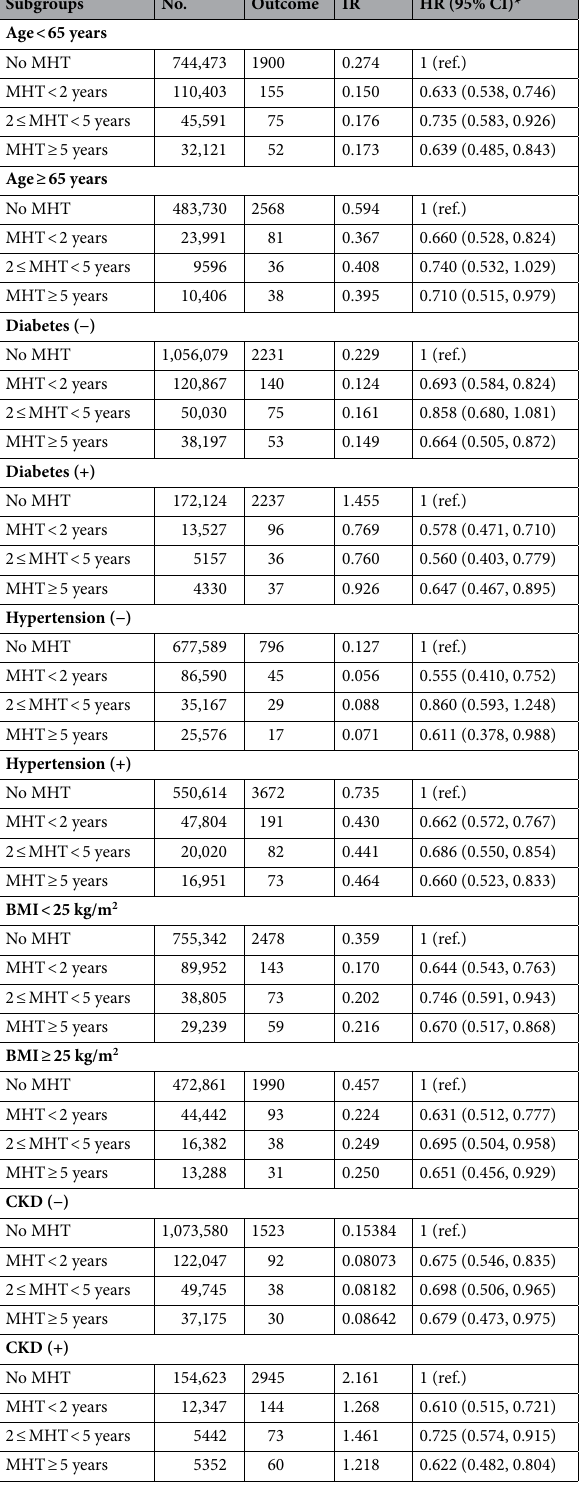
Table 4. Hazard ratios and 95% confidence intervals of ESRD development by history of MHT in subgroups. ESRD end stage renal disease, MHT menopausal hormone therapy, BMI , body mass index, CKD , chronic kidney disease. * HR Cox proportional model adjusted for age, BMI, smoking history, drinking history, degree of exercise, hypertension, dyslipidemia, diabetes, and